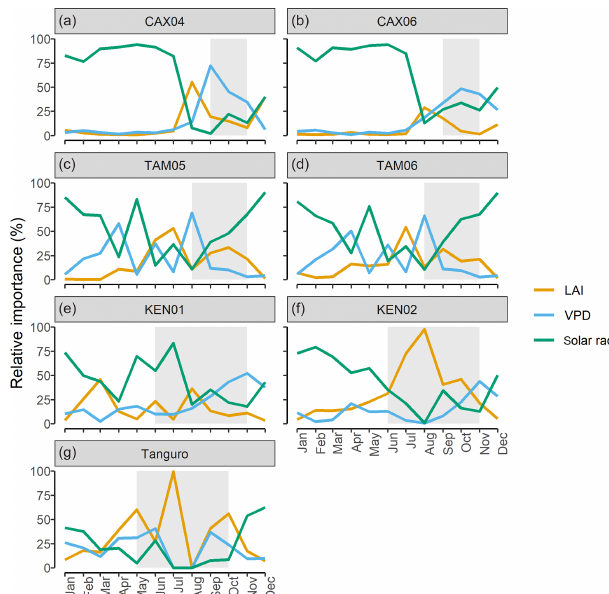
Figure 7. The relative importance (%) of LAI, vapour pressure deficit (VPD) and solar radiation (solar rad) in driving SPA esti- mated monthly photosynthesis at permanent sample plots across an Amazon MCWD gradient. Relative importance was calculated us- ing random forest machine learning. Shaded regions represent the dry season, where monthly precipitation was below 100mm. Plots are ordered to reflect drought stress which increased from Caxiuanã to Tambopata to Kenia and to